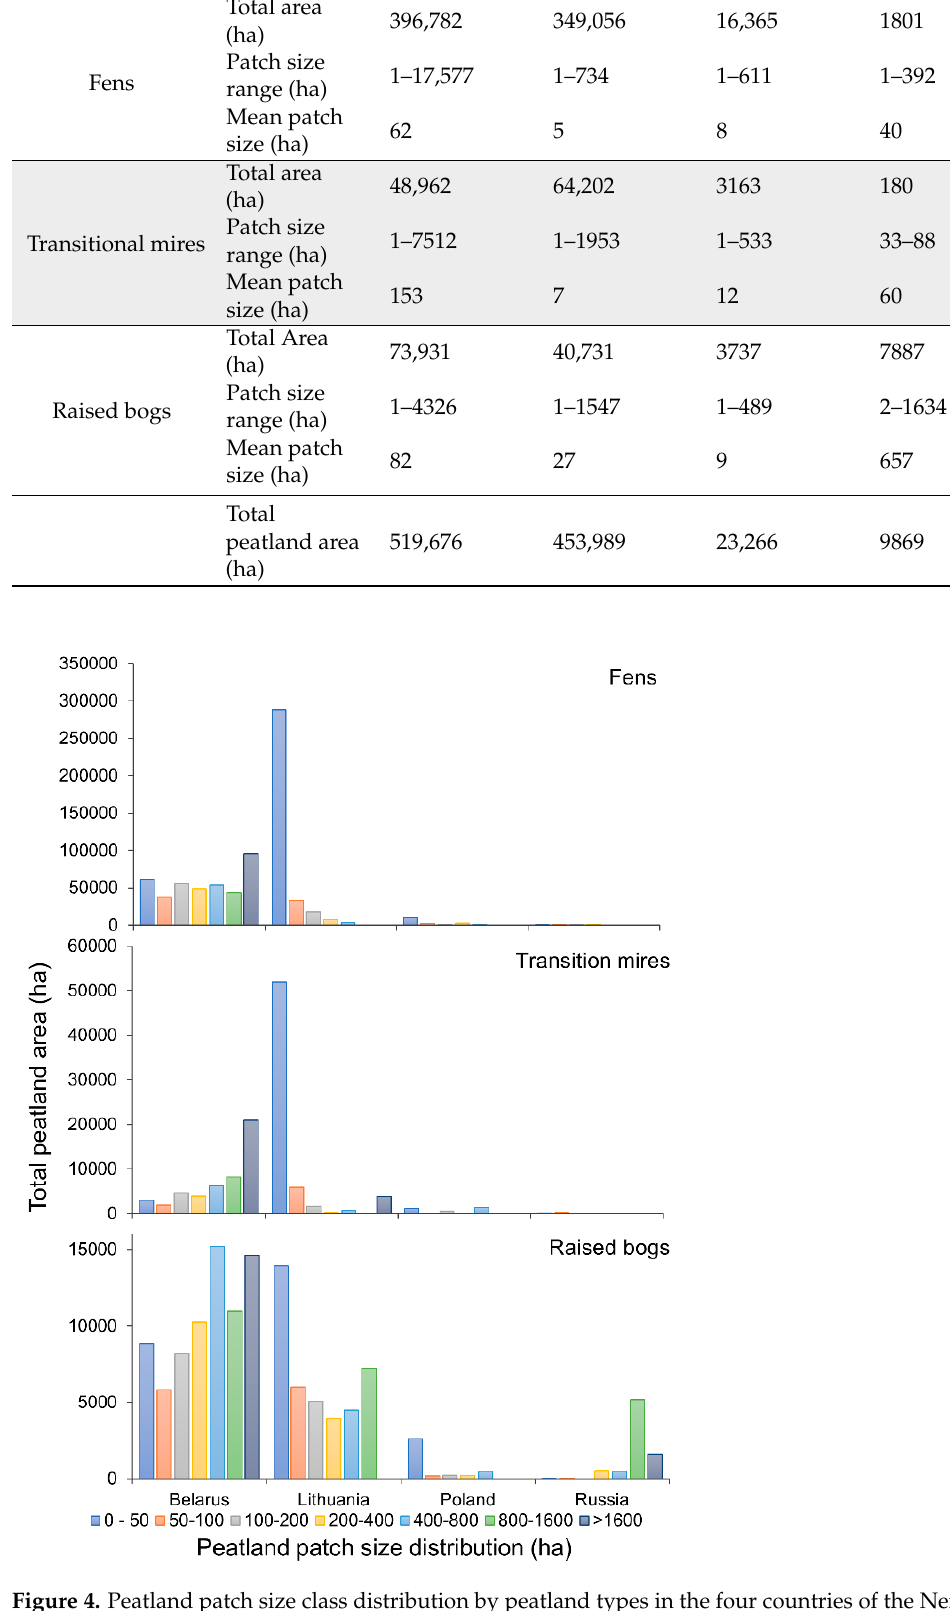
patches size for both fens (62 ha) and transitional mires (153 ha), and Russia for raised bogs (657 ha). The smallest peatland patch size for fens and transitional mires was recorded by Lithuania with 5 and 7 ha, respectively. Poland recorded the smallest mean raised bog patch size with 9 ha (Table 2, Figure 4). Table 2. Peatland distribution of the Neman River basin by country and peatland type.